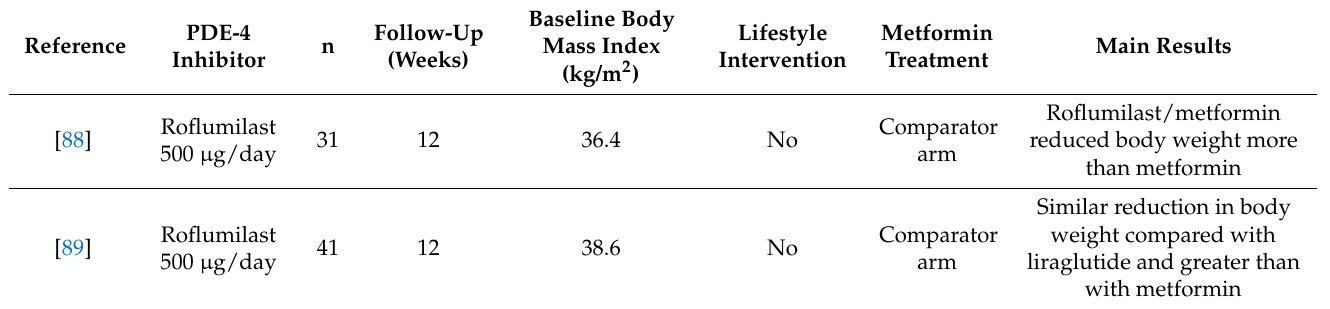
Table 4. Major studies evaluating the effects of phosphodiesterase-4 (PDE-4) inhibitors on obesity in patients with polycystic ovary